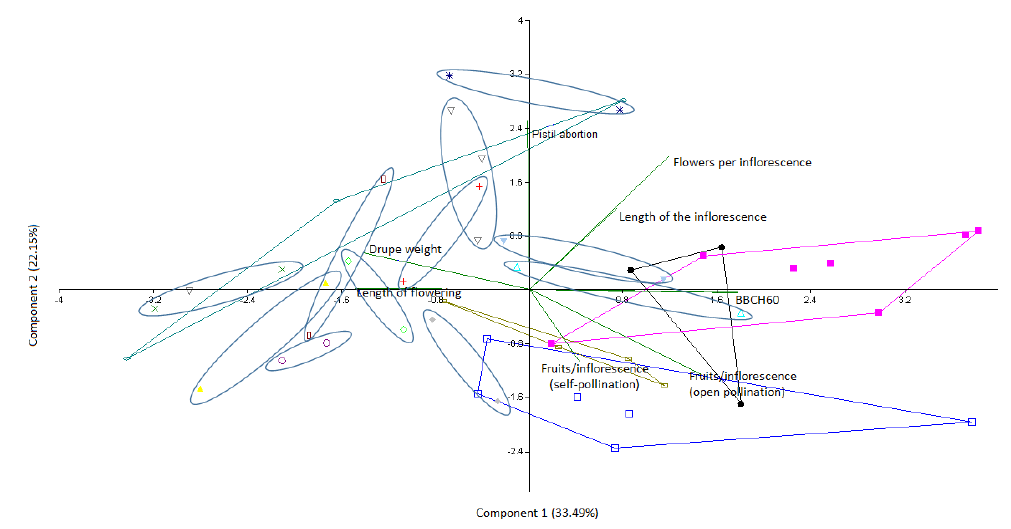
Figure 9. Principal component analysis of the normally distributed physiological parameters obtained from the molecularly revealed cases of synonymy.